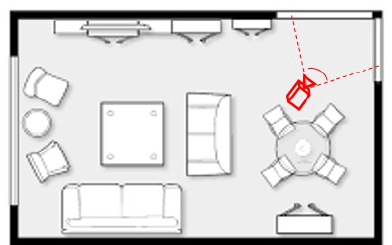
Figure 1. The performance of a vision-based SLAM is influenced by the field of view.